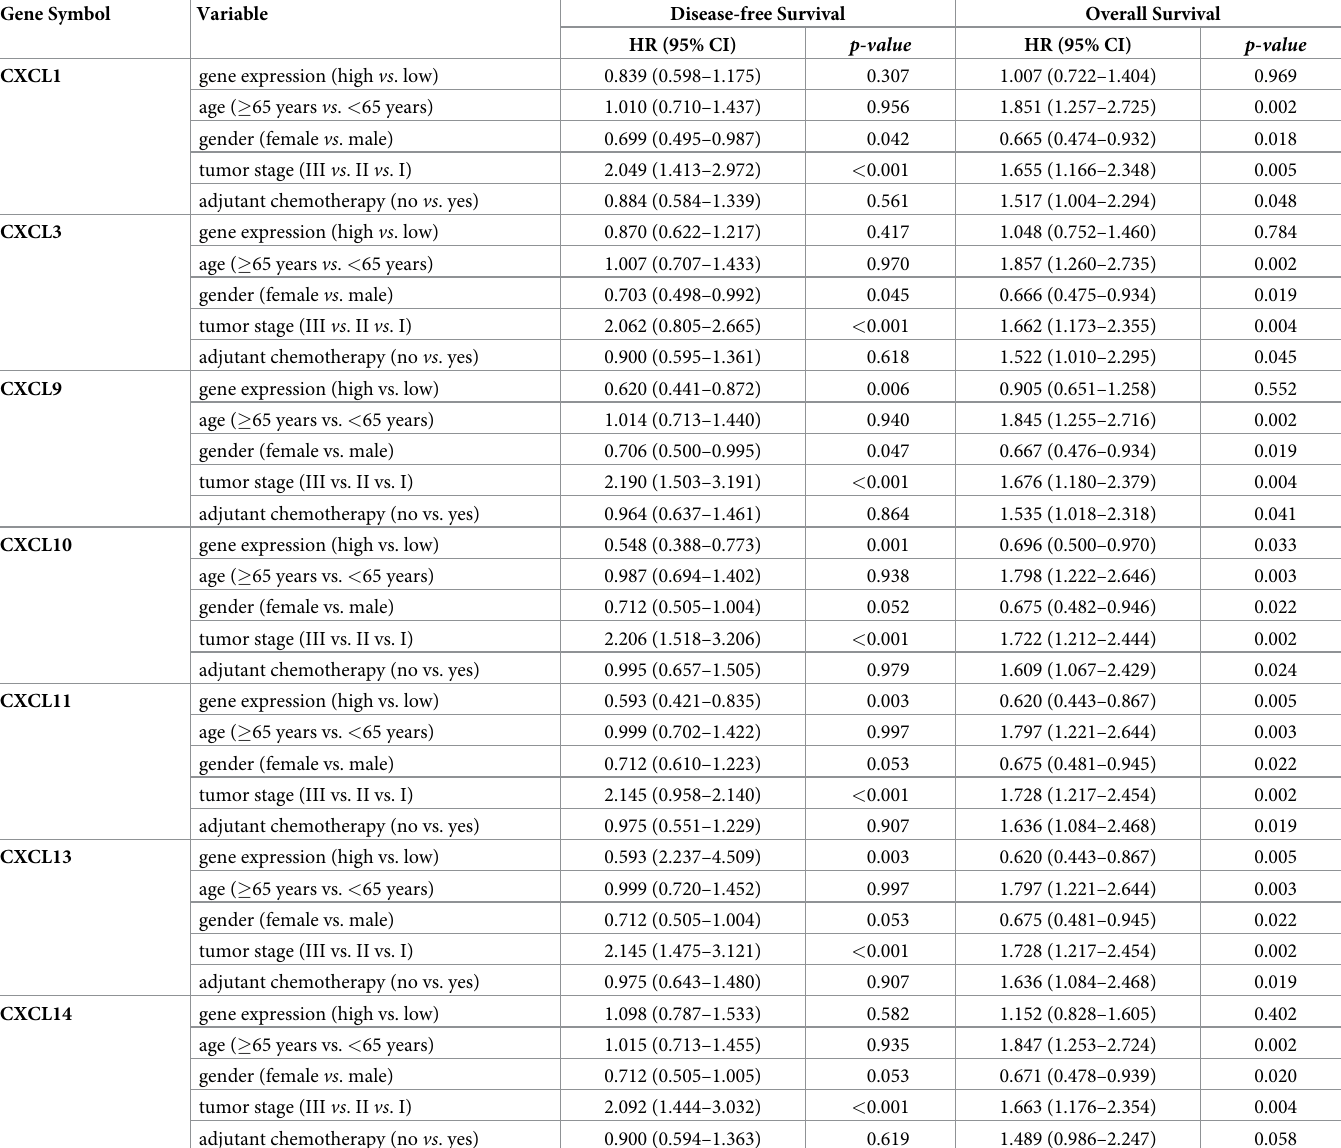
Table 2. Multivariate Cox regression analysis of seven CXC subfamily ligands, gender, age, stage, adjuvant chemotherapy, and survival in dataset GSE39582 (n = 492). Gene